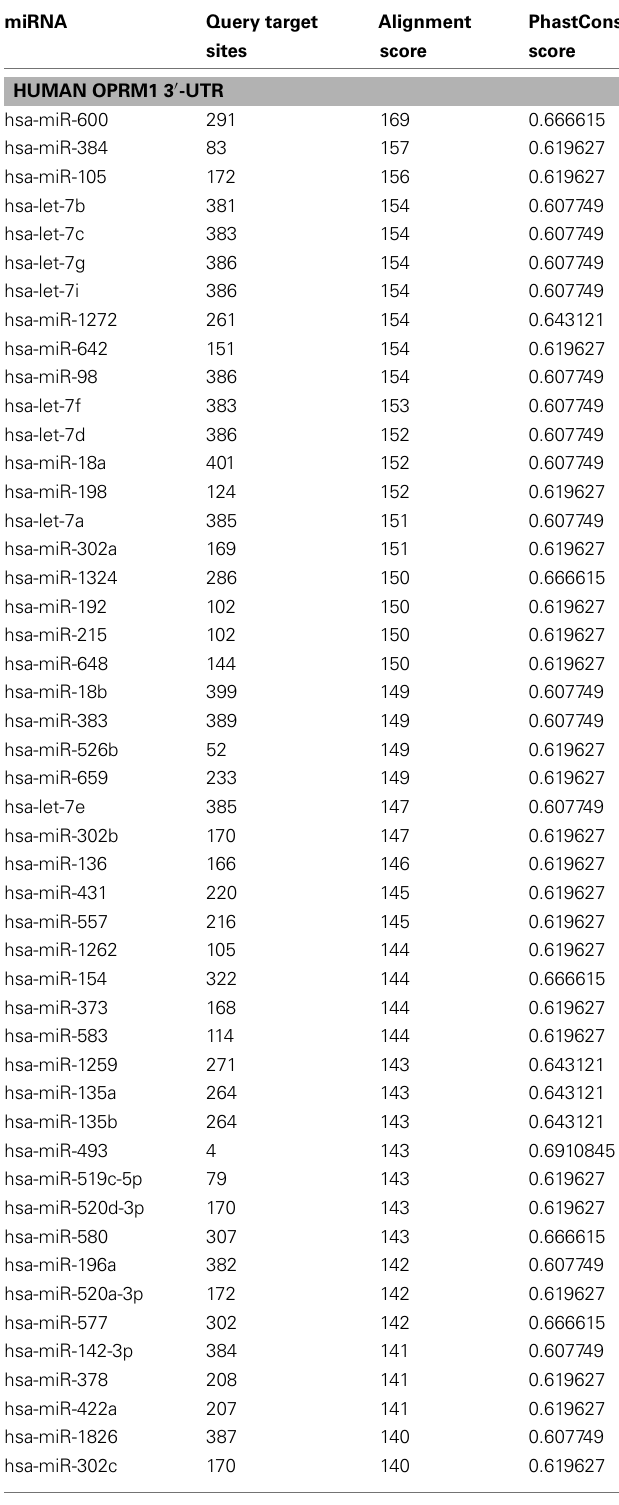
(http://www.microrna.org/microrna/getGeneForm.do) and ranked according to the alignment